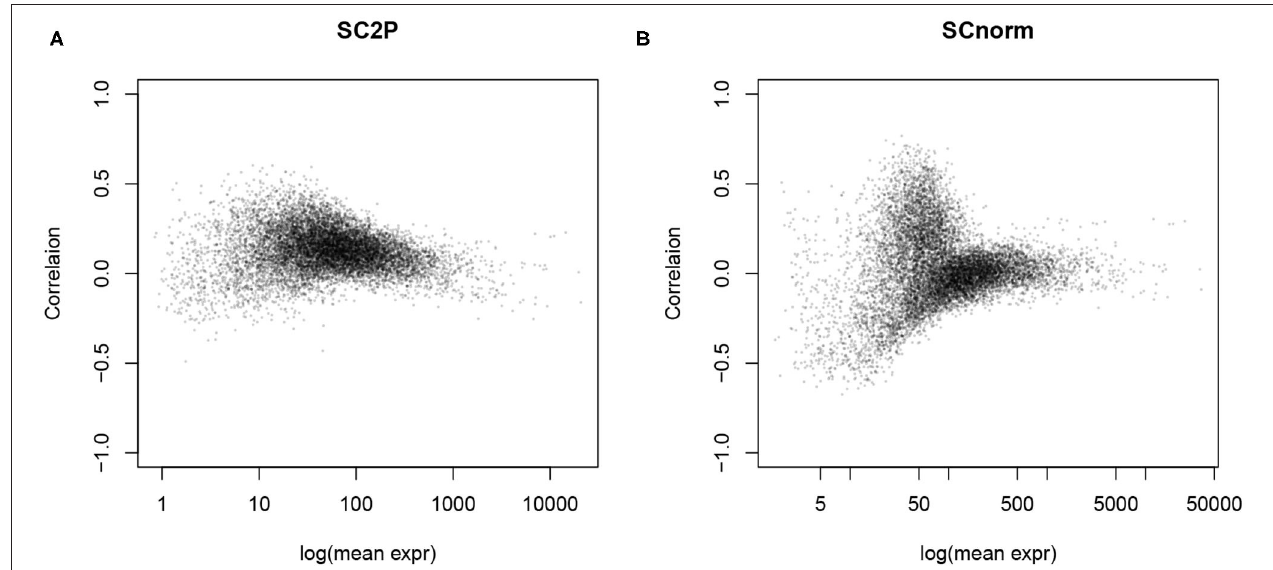
FIGURE 4 | The count-depth relationship, measured as the correlation between the (normalized) gene counts and library size, is reduced after normalization. (A) Normalized by SC2P normalization. (B) Normalized by SCnorm.